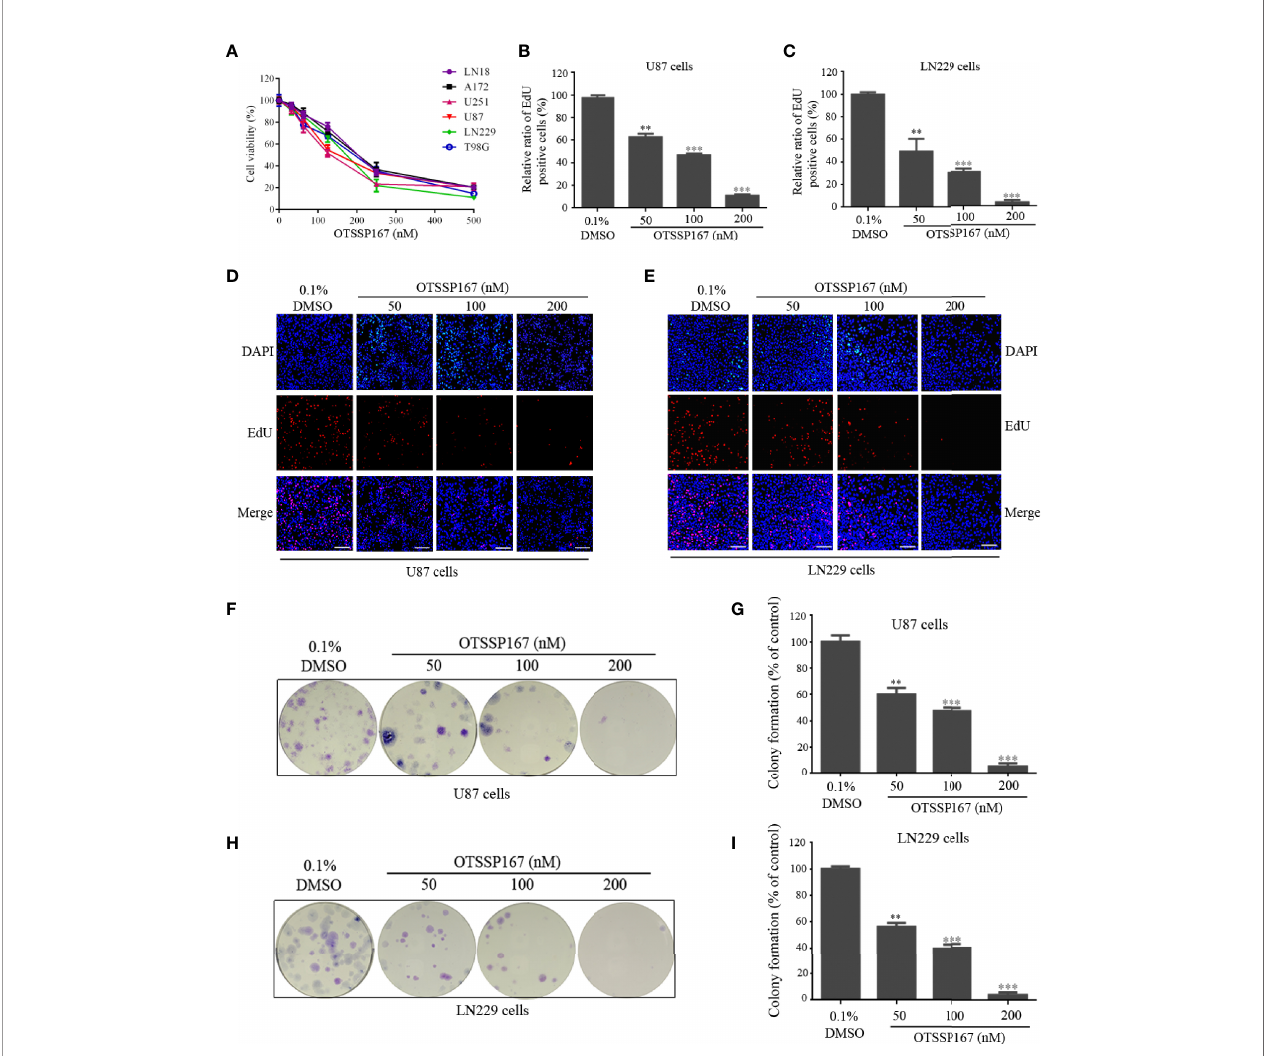
FIGURE 1 | OTSSP167 inhibits GBM cell proliferation and colony formation. (A) CCK-8 viability analysis of cells treated with six OTSSP167 concentrations, including 0 nM, 31.25 nM, 62.5 nM, 125 nM, 250 nM, and 500 nM for 72 h. (B – E) The U87 and LN229 cells were treated with indicated concentrations of OTSSP167 for 24 h, and the EdU assay was performed to assess cell proliferation. Panels (B, C) show the results of the quantitative analysis of the EdU test; panels (D, E) show the representative images of EdU analysis after OTSSP167 treatment of the U87 and LN229 cells. (F – I) OTSSP167 inhibits colony formation in U87 and LN229 cells in a dose-dependent manner. Quantitative analysis of the results of the colony formation experiment was performed. All the Data are presented as means ± SEM. ** P < 0.01, *** P < 0.001 compared with the 0.1% DMSO treated